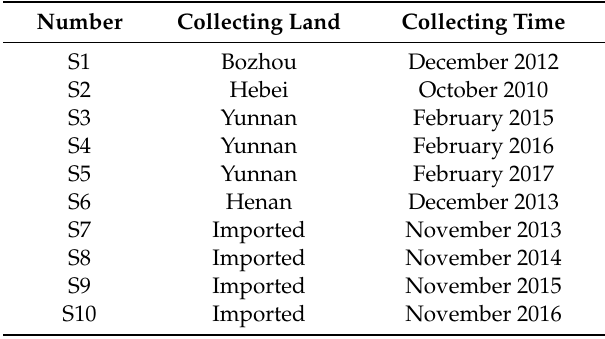
Table 3. Information about the collected P.